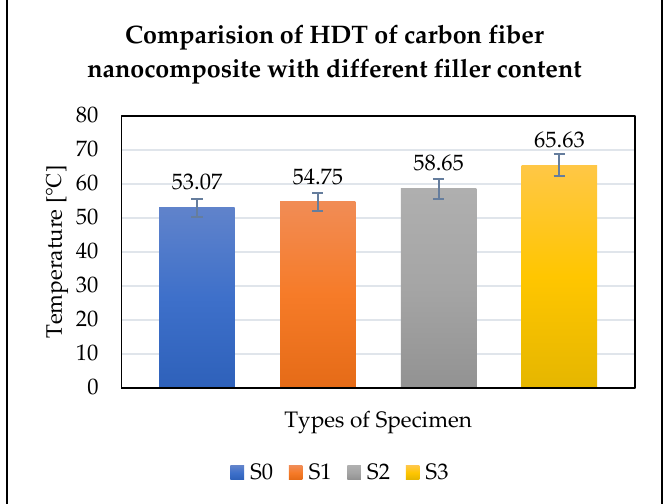
Figure 9. Heat deflection temperature (HDT).